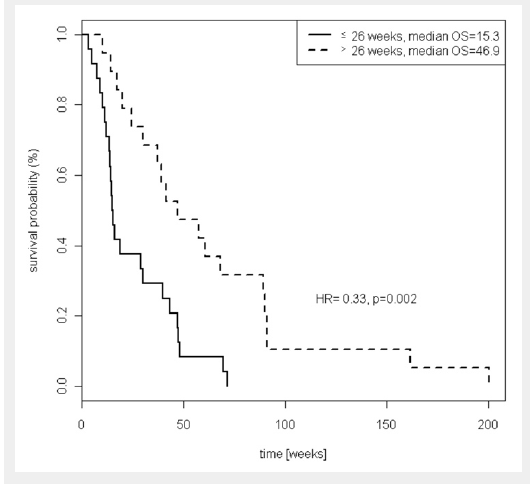
Kaplan-Meier estimates of overall survival by progression free survival at 1 st line chemotherapy, less than or equal to 26 weeks versus greater than 26 weeks.